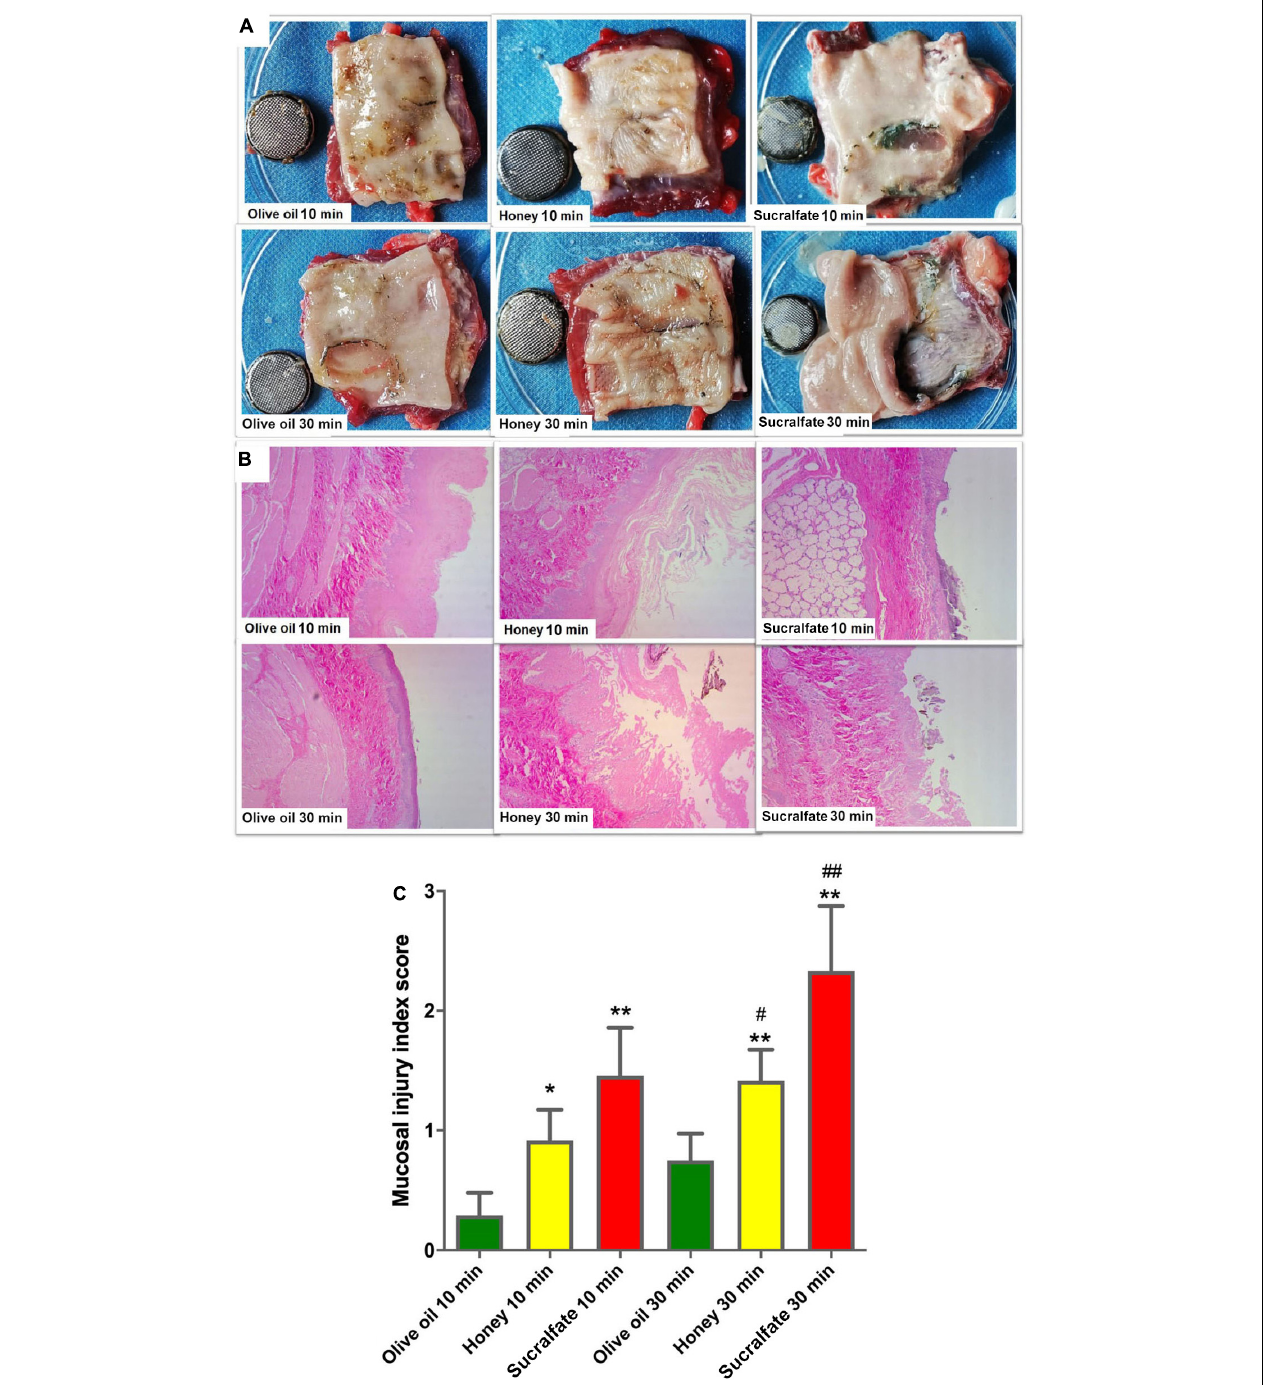
FIGURE 1 | The effect of different treatments on esophageal injury after button-battery ingestion in vitro ( n = 6). (A) The gross damage of segmented esophagus irrigated at 10 min (upper) or 30 min (lower) interval. (B) Hematoxylin and eosin staining of button battery-exposed esophageal segments after different treatments. (C) Mucosal injury index score based on hematoxylin and eosin staining. * P < 0.05 vs. Olive oil 10 min; # P < 0.05 vs. Olive oil 30 min; ** P < 0.01 vs. Olive oil 10 min; # P < 0.01 vs. Olive oil 30 min. Figure 4A . In saline treated esophagus, there was deep necrosis and almost all layers of esophageal wall were severely